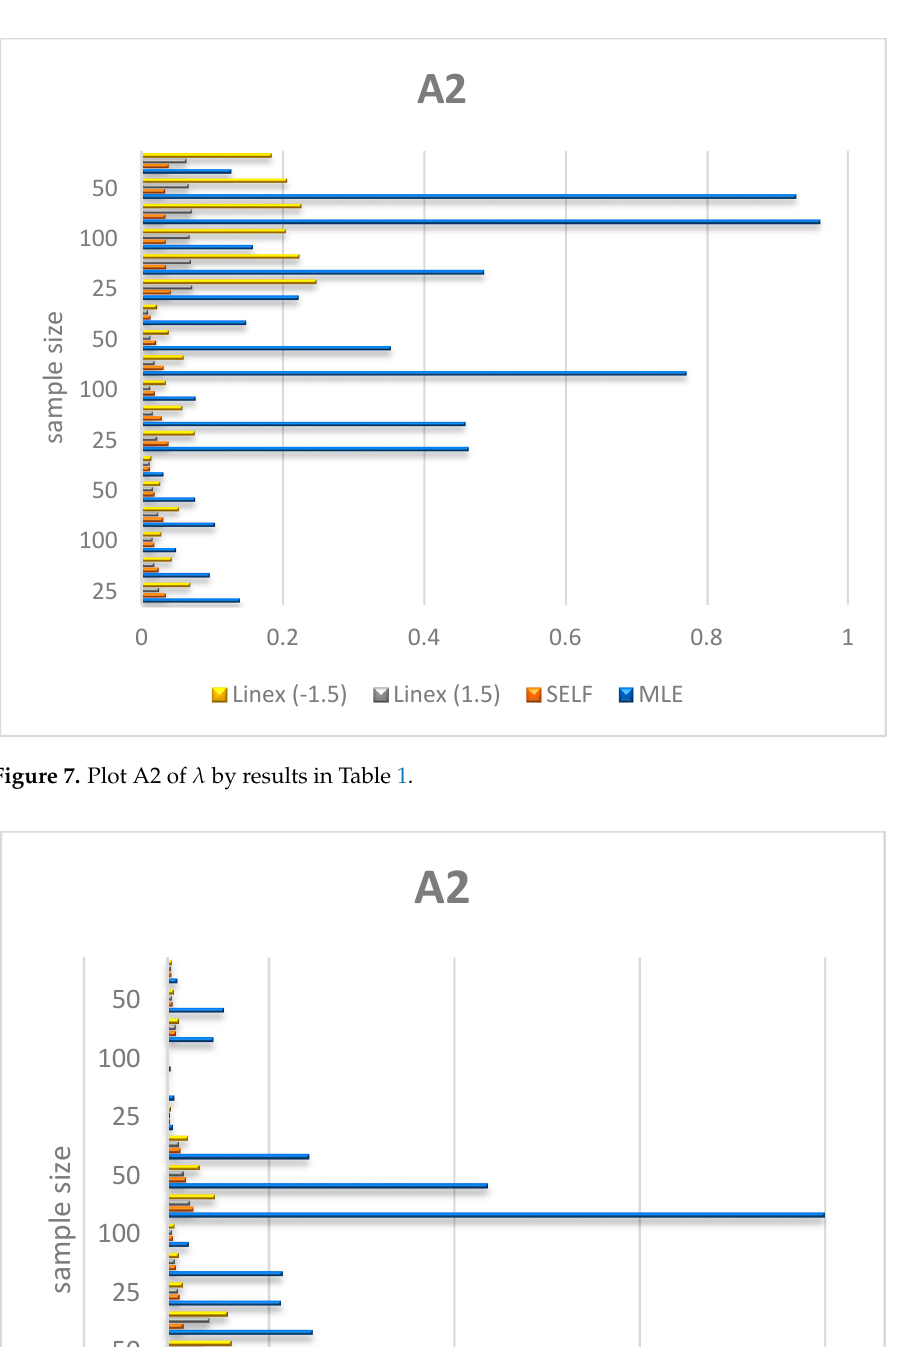
Figure 8. Plot A2 of 𝜇 by results in Table 1.